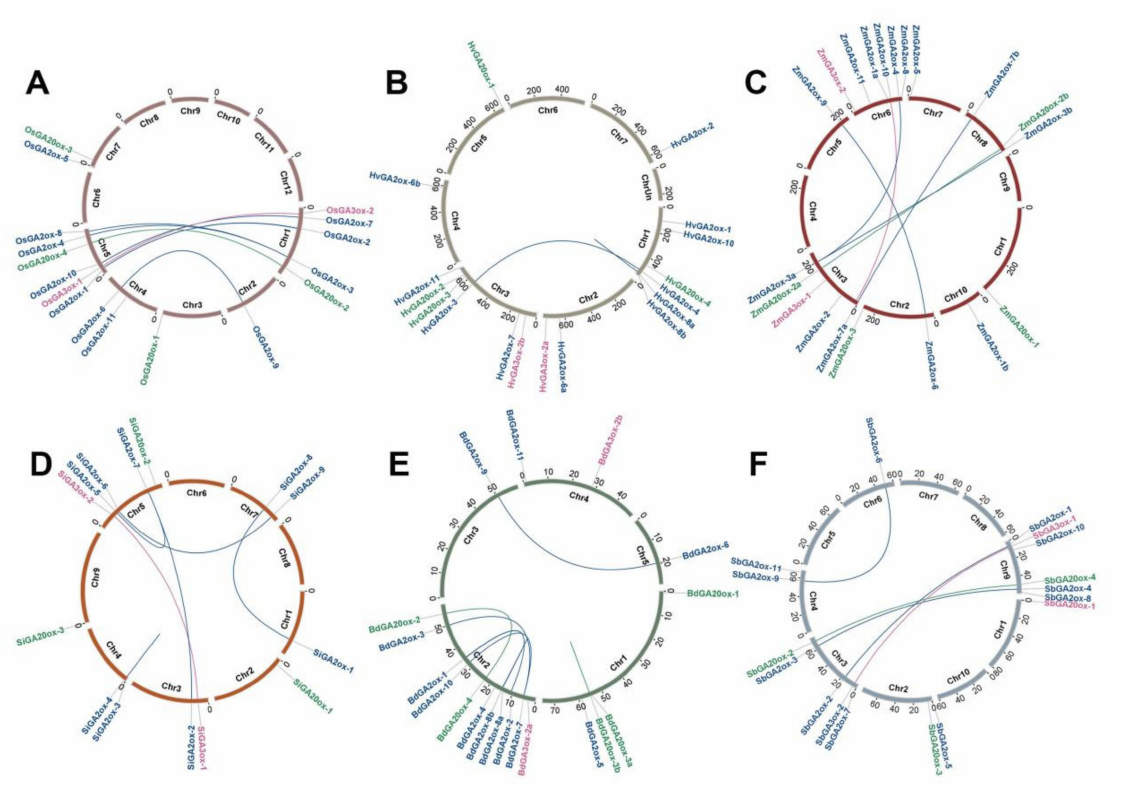
Figure 2. The chromosome location and duplication events of GAox genes in six species, namely, O. sativa ( A ), H. vulgare ( B ), Z. mays ( C ), S. italica ( D ), B. distachyon ( E ), and S. bicolor ( F ). The blue, purple, and green lines, respectively, represent the duplication events within the GA2ox, GA3ox, and GA20ox genes in each